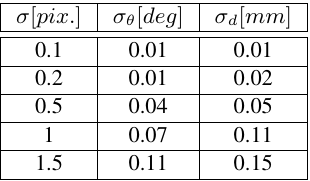
Table 2. Accuracy measures for the position and orientation esti- mation of the central-line